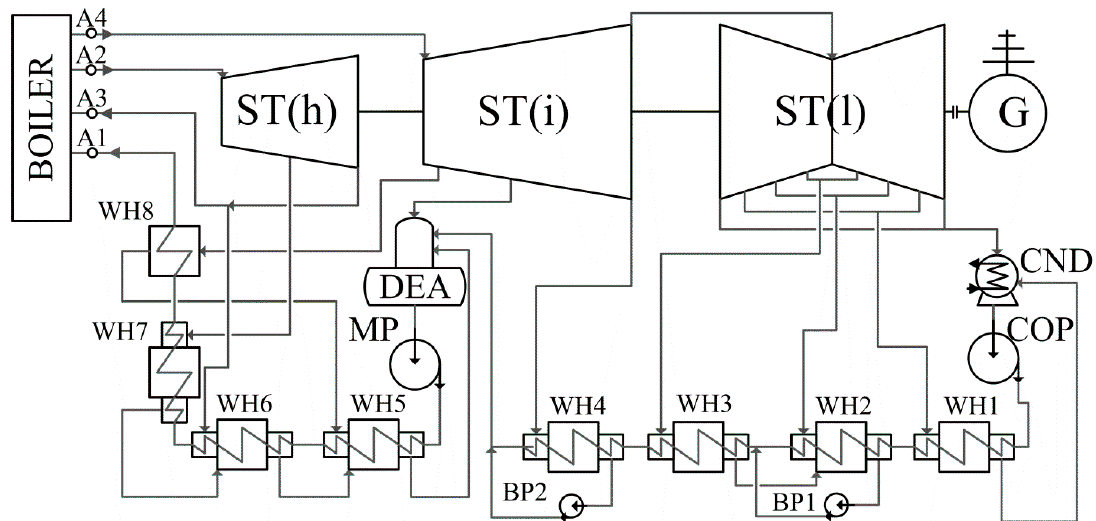
Figure 2. Scheme of the steam turbine unit (BP–bleeds condensate pump; CND–condenser; COP–condensate pump; DEA–deaerator; MP–main pump; ST–steam turbine; (h)–high pressure; (i)–intermediate pressure; (l)–low pressure; WH–feedwater heater).